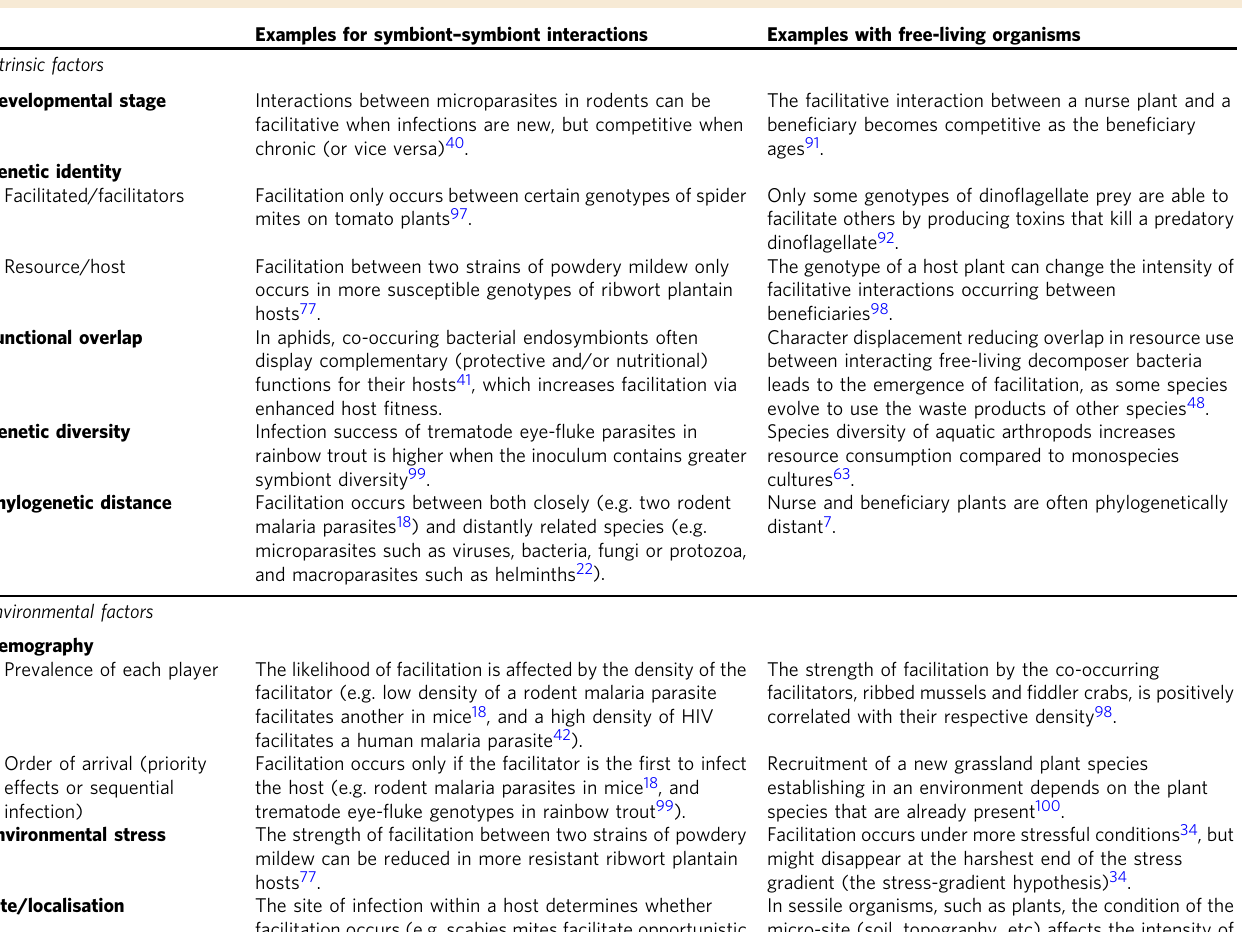
Table 1 Factors affecting the likelihood or strength of facilitation between symbionts and parallel examples for free-living